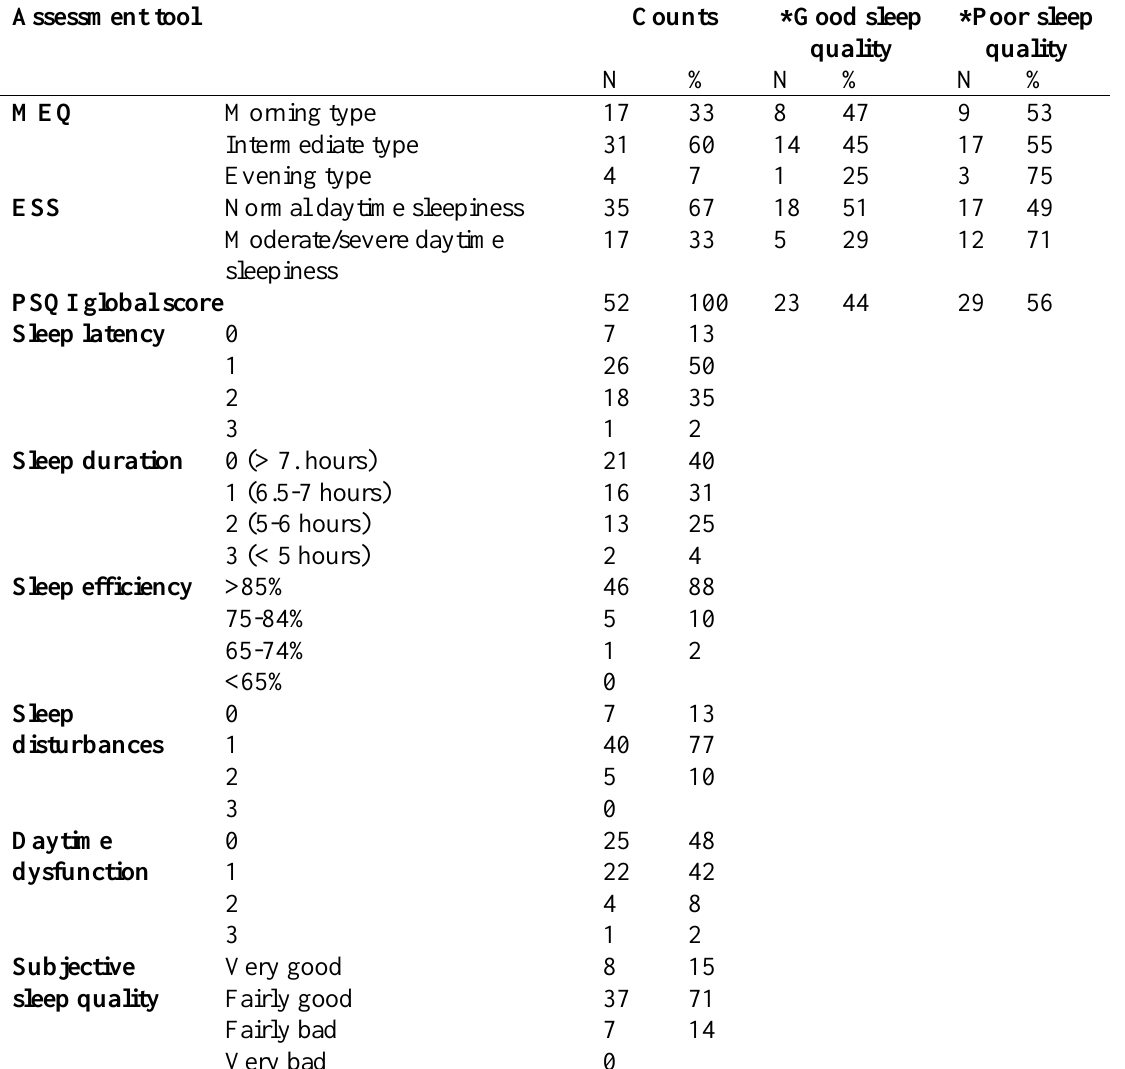
Table 1. Sleep related outcome divided into “good sleep” and “poor sleep” subgroups